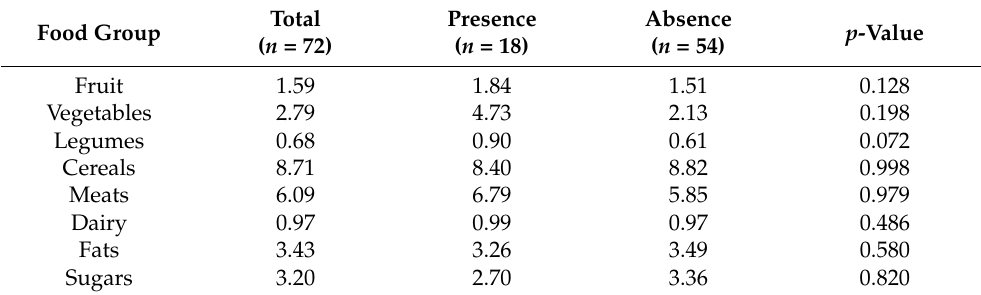
Table 4. Food consumption in the presence of abdominal obesity. Food